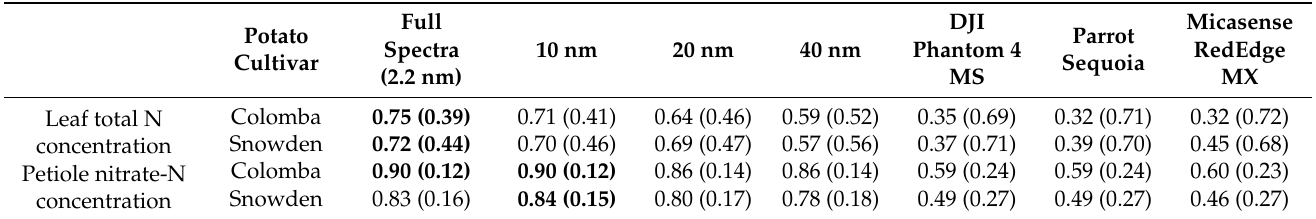
Table 4. Model performance grouped by the two potato cultivars for the hyperspectral narrow and broad bands and the synthesized multispectral